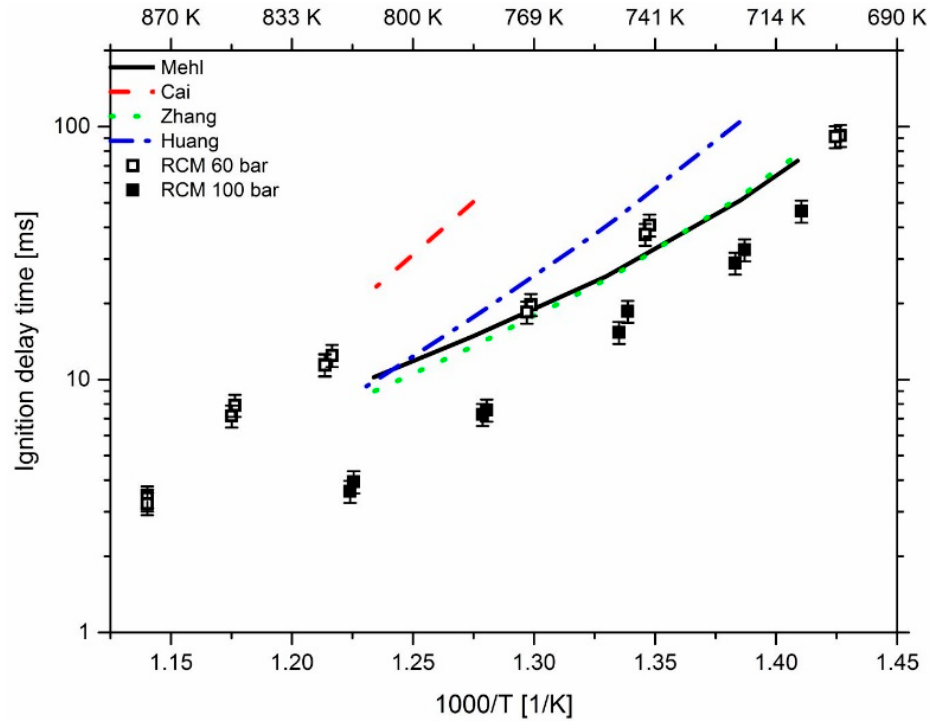
Figure 16. Experimental RCM data at P c = 60 and 100 bar using 95 mol % CH 4 , 5 mol % C 3 H 8 and x n-C (cid:3123) (cid:2892) (cid:3117)(cid:3122) = 0.025 at λ global = 1.685 versus the model prediction at 100 bar.